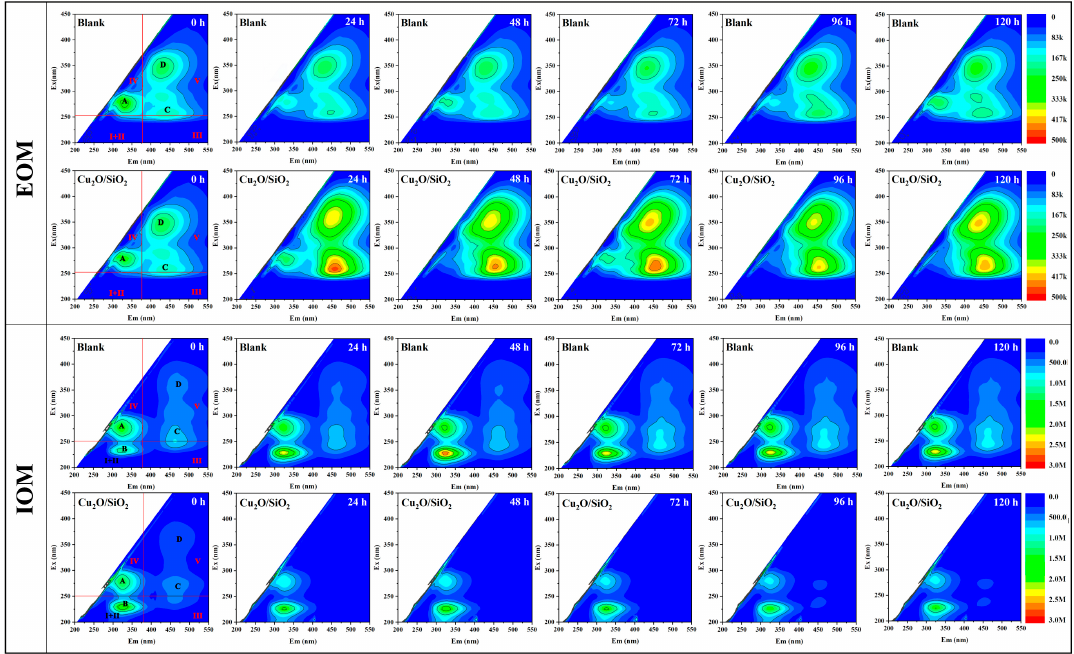
Figure 8. The fluorescence spectrum of extracellular organic matter (EOM) & intracellular organic matter (IOM) of algae cells.